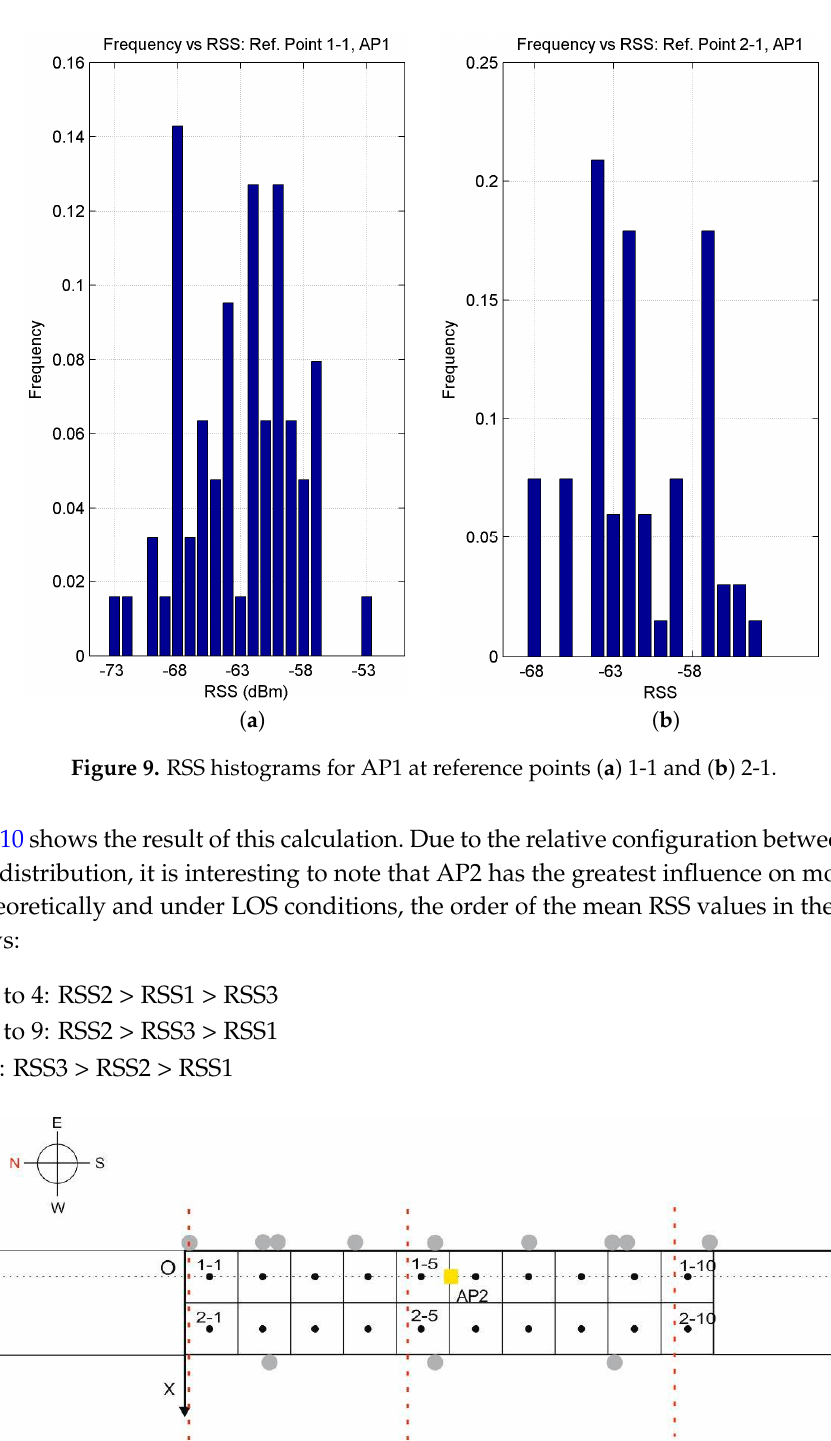
Figure 8. RSS vs time for point TP4 and the three APs.